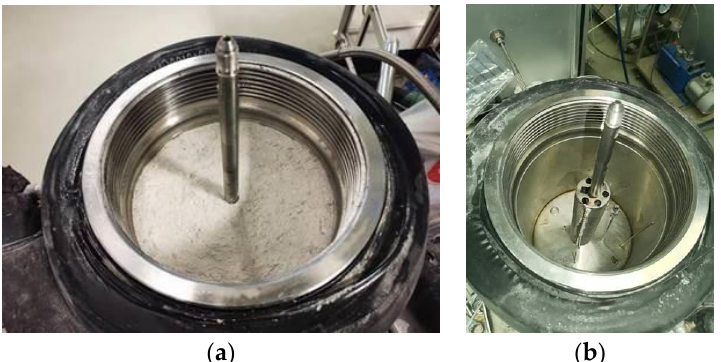
Figure 8. ( a ) Compacted sand in the kettle; ( b ) Gravel packing device pre-positioned in the reactor.